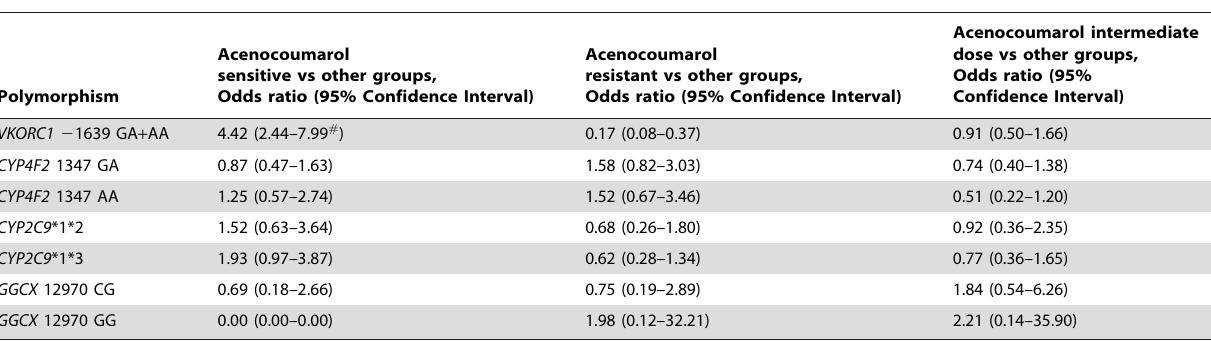
Table 5. Association between acenocoumarol sensitive/resistant/intermediate dose groups and polymorphisms.